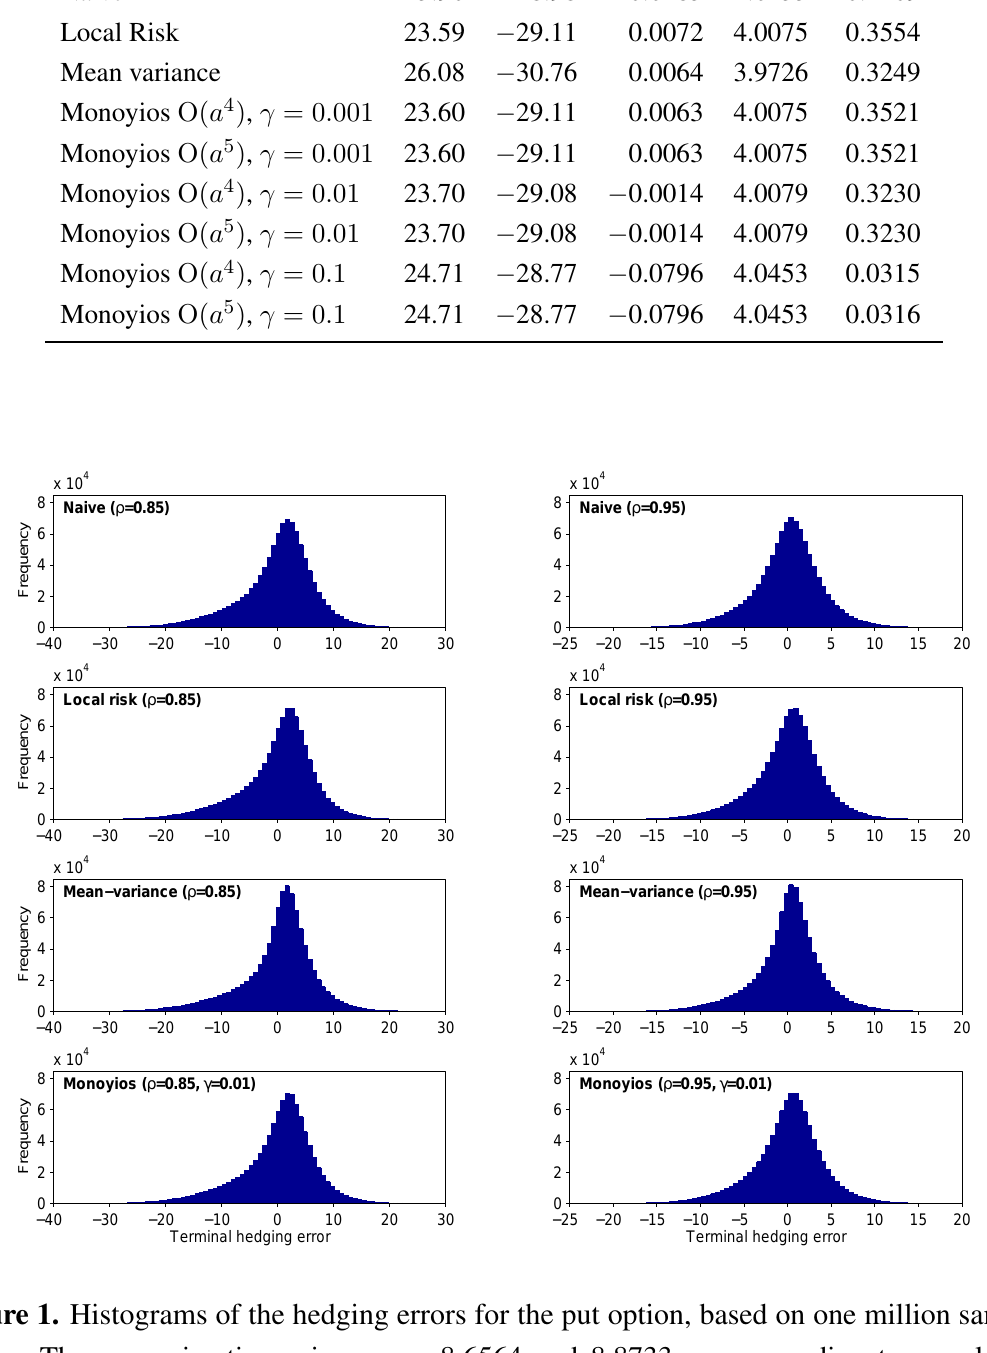
Figure 1. Histograms of the hedging errors for the put option, based on one million sample paths. The approximation prices were 8.6564 and 8.8733, corresponding to correlation coefficients of 0.85 and 0.95,